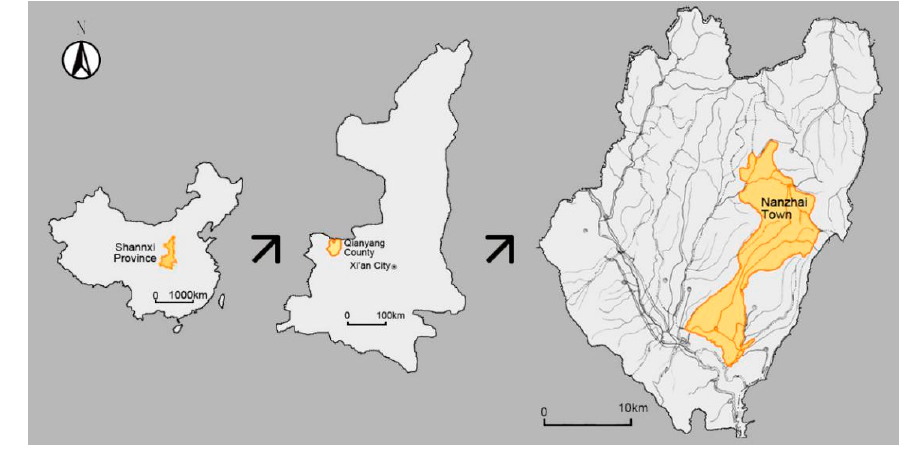
Figure 4. Location of Nan Zhai town. Table 2. Overview of three different kinds of residential buildings.